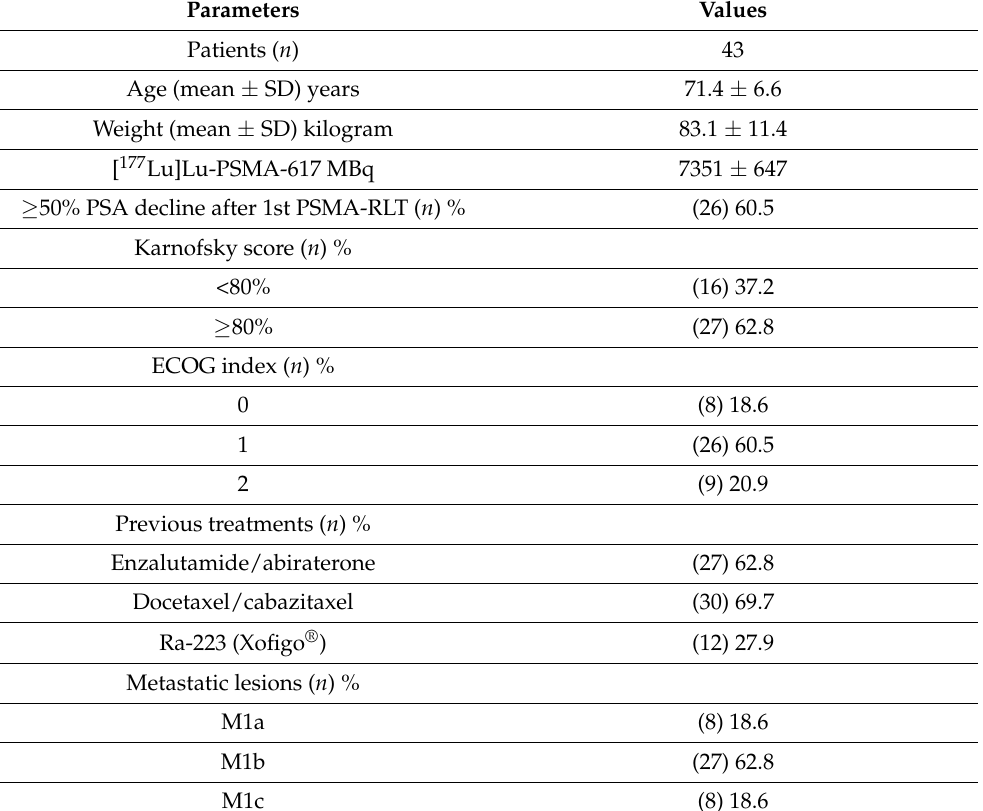
Table 1. Clinical characteristics of the studied mCRPC patients prior to obtaining the second PSMA- RLT